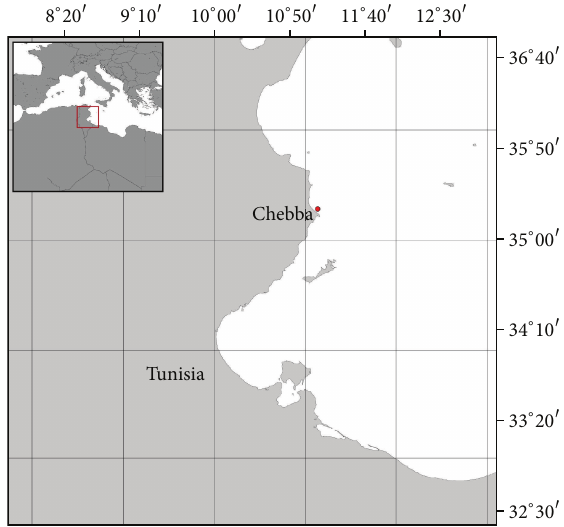
Figure 1: Map of the study area, showing the sampling